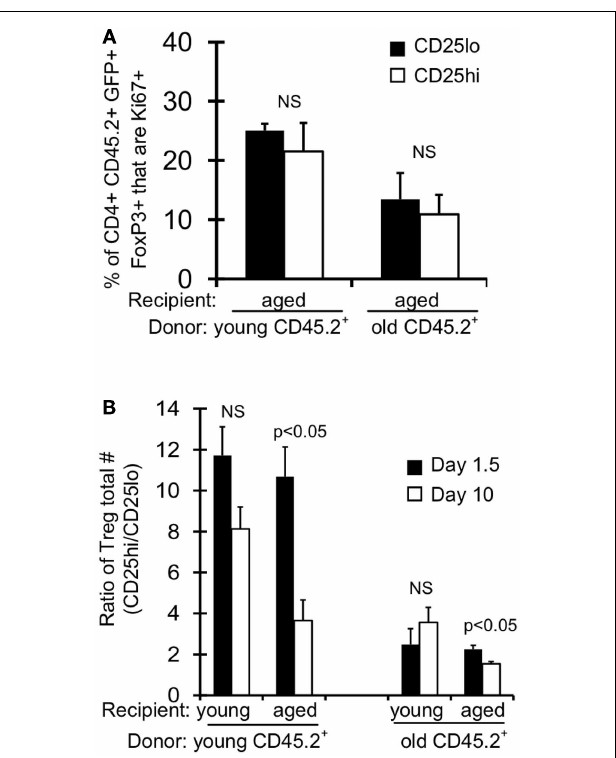
FIGUREA1 |Absolute numbers and proliferation ofTreg post-adoptive transfer . CD + FoxP3 GFP + T cells were sorted from splenocytes of young (3–4months) and old ( > 18months) CD45.2 FoxP3 GFP reporter mice. About 5 × 10 5 CD4 + FoxP3 GFP + cells were injected i.v. into young (2months) and aged (15months) congenic CD45.1 mice. Mice were sacrificed at day 1.5 ( n = 3–5/group) and day 10 ( n = 3–5/group) post-injection. Cells from the spleen were stained for CD4, CD25, CD45.2, and intracellularly for FoxP3 and Ki67 and analyzed by flow. (A) Results show the frequency of CD4 + CD45.2 + FoxP3 + GFP + CD25 lo and CD25 hi cells that are Ki67 + on day 10 post-transfer into aged recipient mice ( ± SE). (B) Results show the numbers ratio of CD25 hi to CD25 lo CD4 + CD45.2 + FoxP3 + GFP + cells ( ±